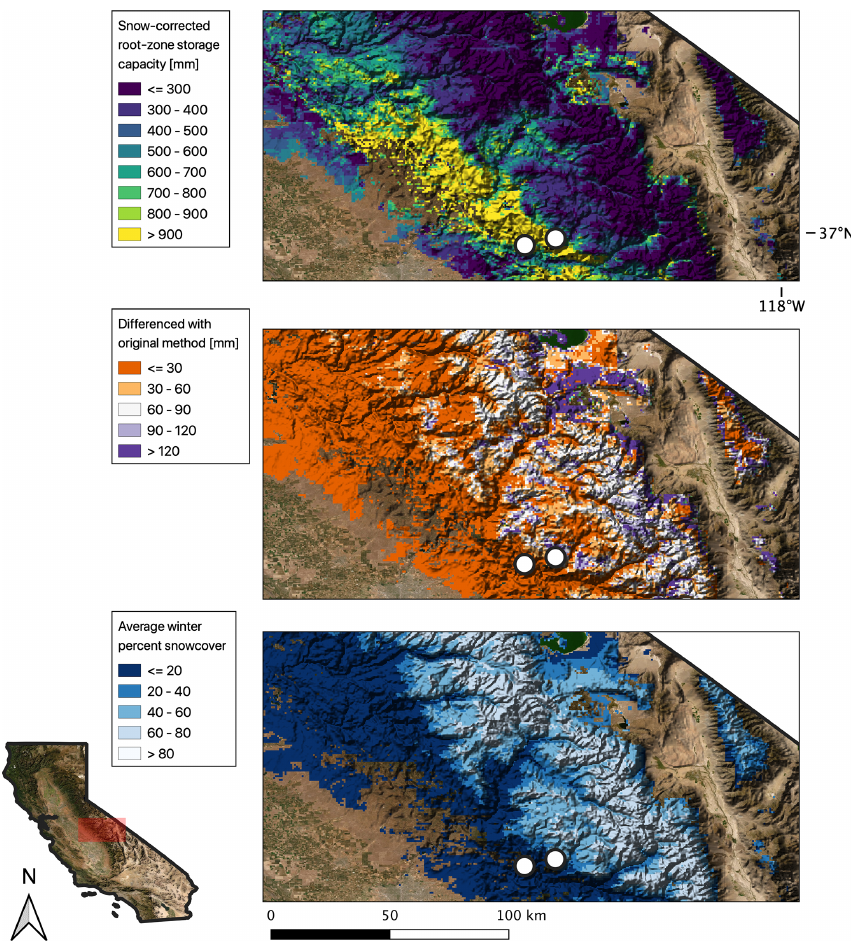
Figure 1. Maps of snow-corrected S R (a) , the difference between the original and snow-corrected S R (b) , and average winter (January–April) percent snow cover (c) over a region of the Southern Sierra Nevada, California, USA. White points identify rain-dominated (western) and snowy (eastern) locations highlighted in Fig. 2. Imagery was obtained from publicly available data through the US Department of Agriculture, Farm Service Agency’s National Agriculture Imagery